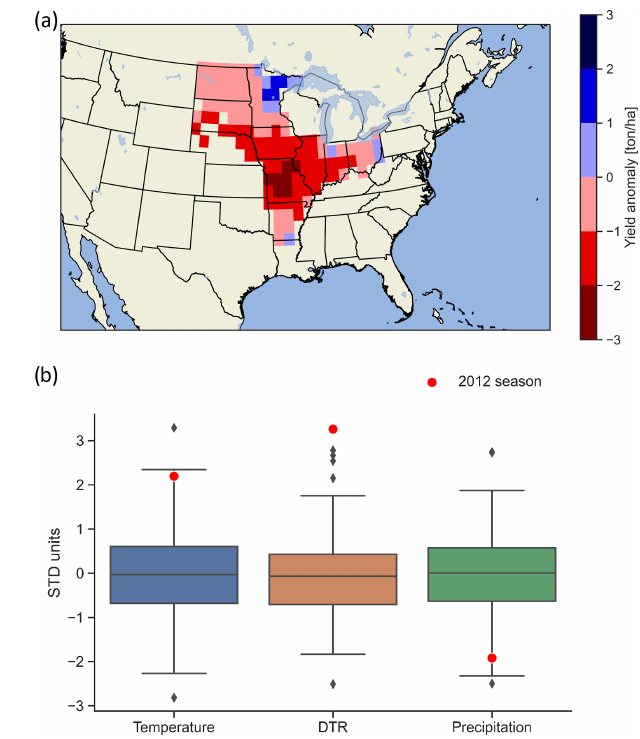
Figure 9. (a) Map of the yield anomaly for the 2012 season compared to the averaged historical yield data from EPIC-IIASA. (b) Normalised meteorological variables for the observed dataset and the corresponding 2012 season climatic